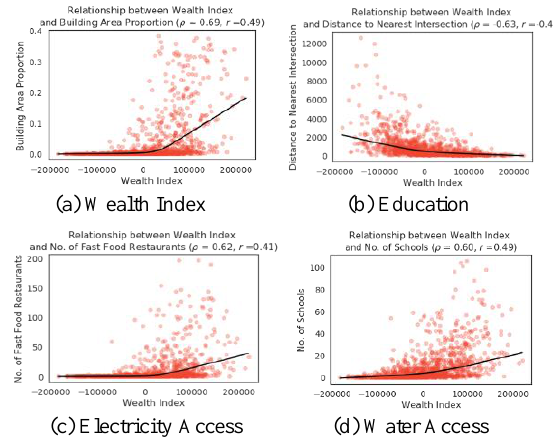
Figure 2. Relationship between cluster-level asset-based wealth and different covariates extracted from OSM. Black line indicates a LOESS curve fitted to the